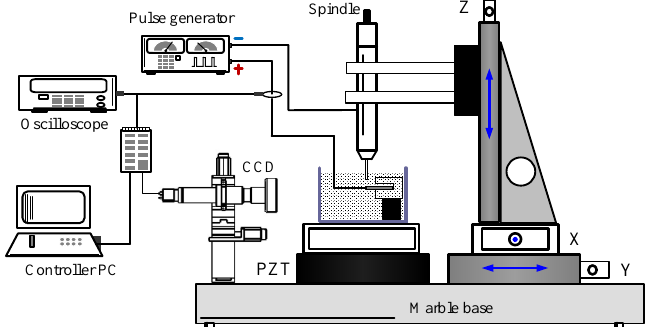
Figure 3. Schematic of experimental apparatus. Note: CCD = charge-coupled device; PZT = Piezoelectric Transducer.